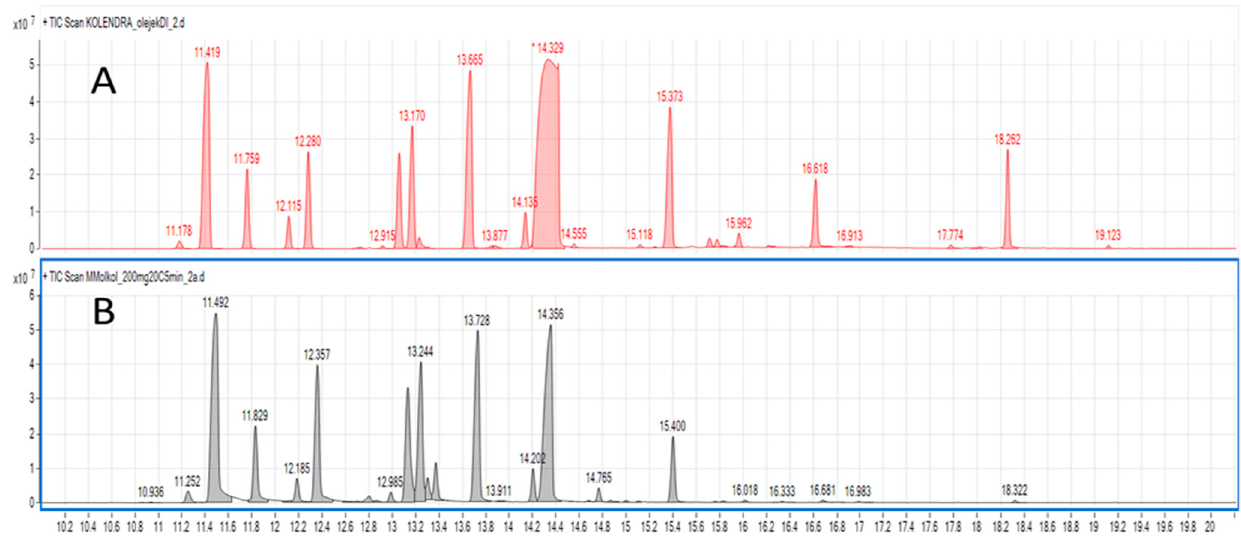
Figure 3. TIC chromatograms of coriander terpenes obtained after hydrodistillation of coriander cold pressed oil ( A ) and after VASE extraction ( B ).